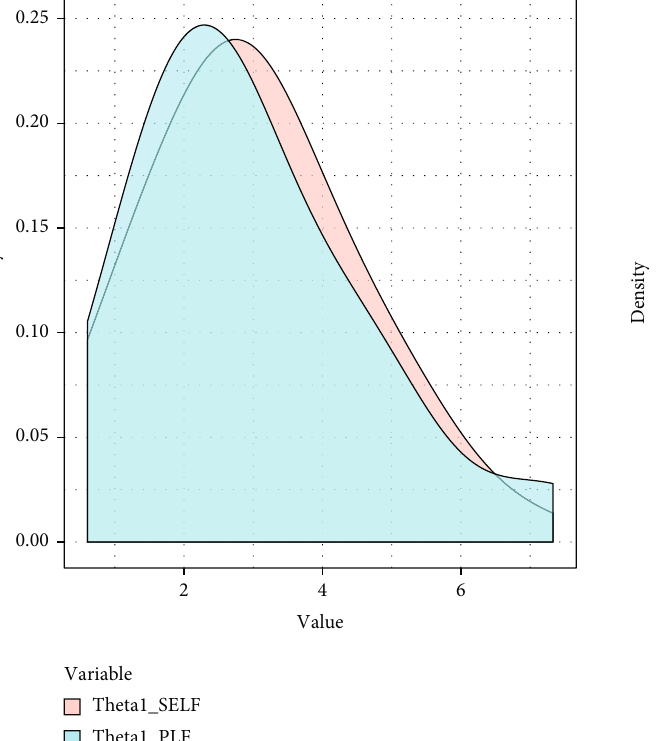
Figure 7: The marginal density for θ